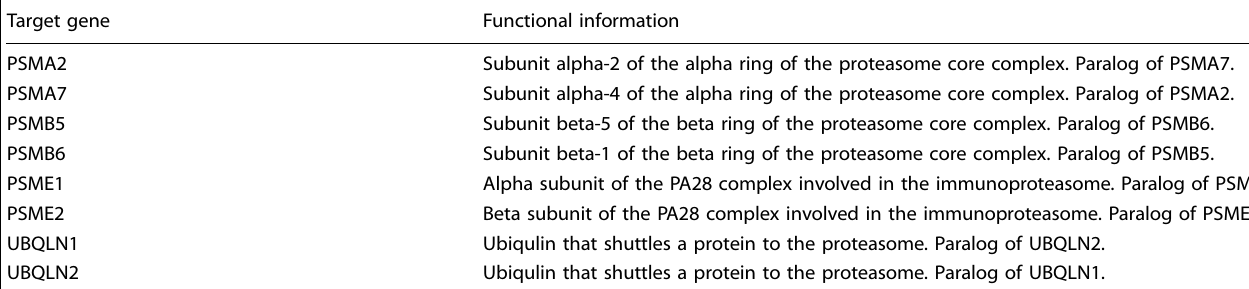
Table 1. List of the target genes for creating mutant cells. Target gene Functional